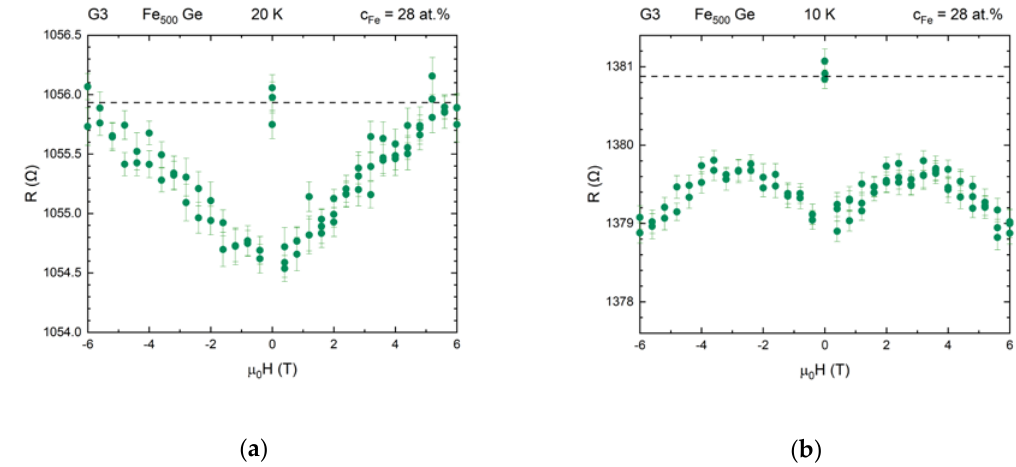
Figure 17. Absolute resistance vs. applied magnetic field at constant temperature. ( a ) At 20 K sample G3 shows an almost-linear in field positive magnetoresistance. ( b ) At 10 K a stronger negative e ff ect is superimposed and changes the slope to negative at about 3 T. Such behavior was observed for most samples.